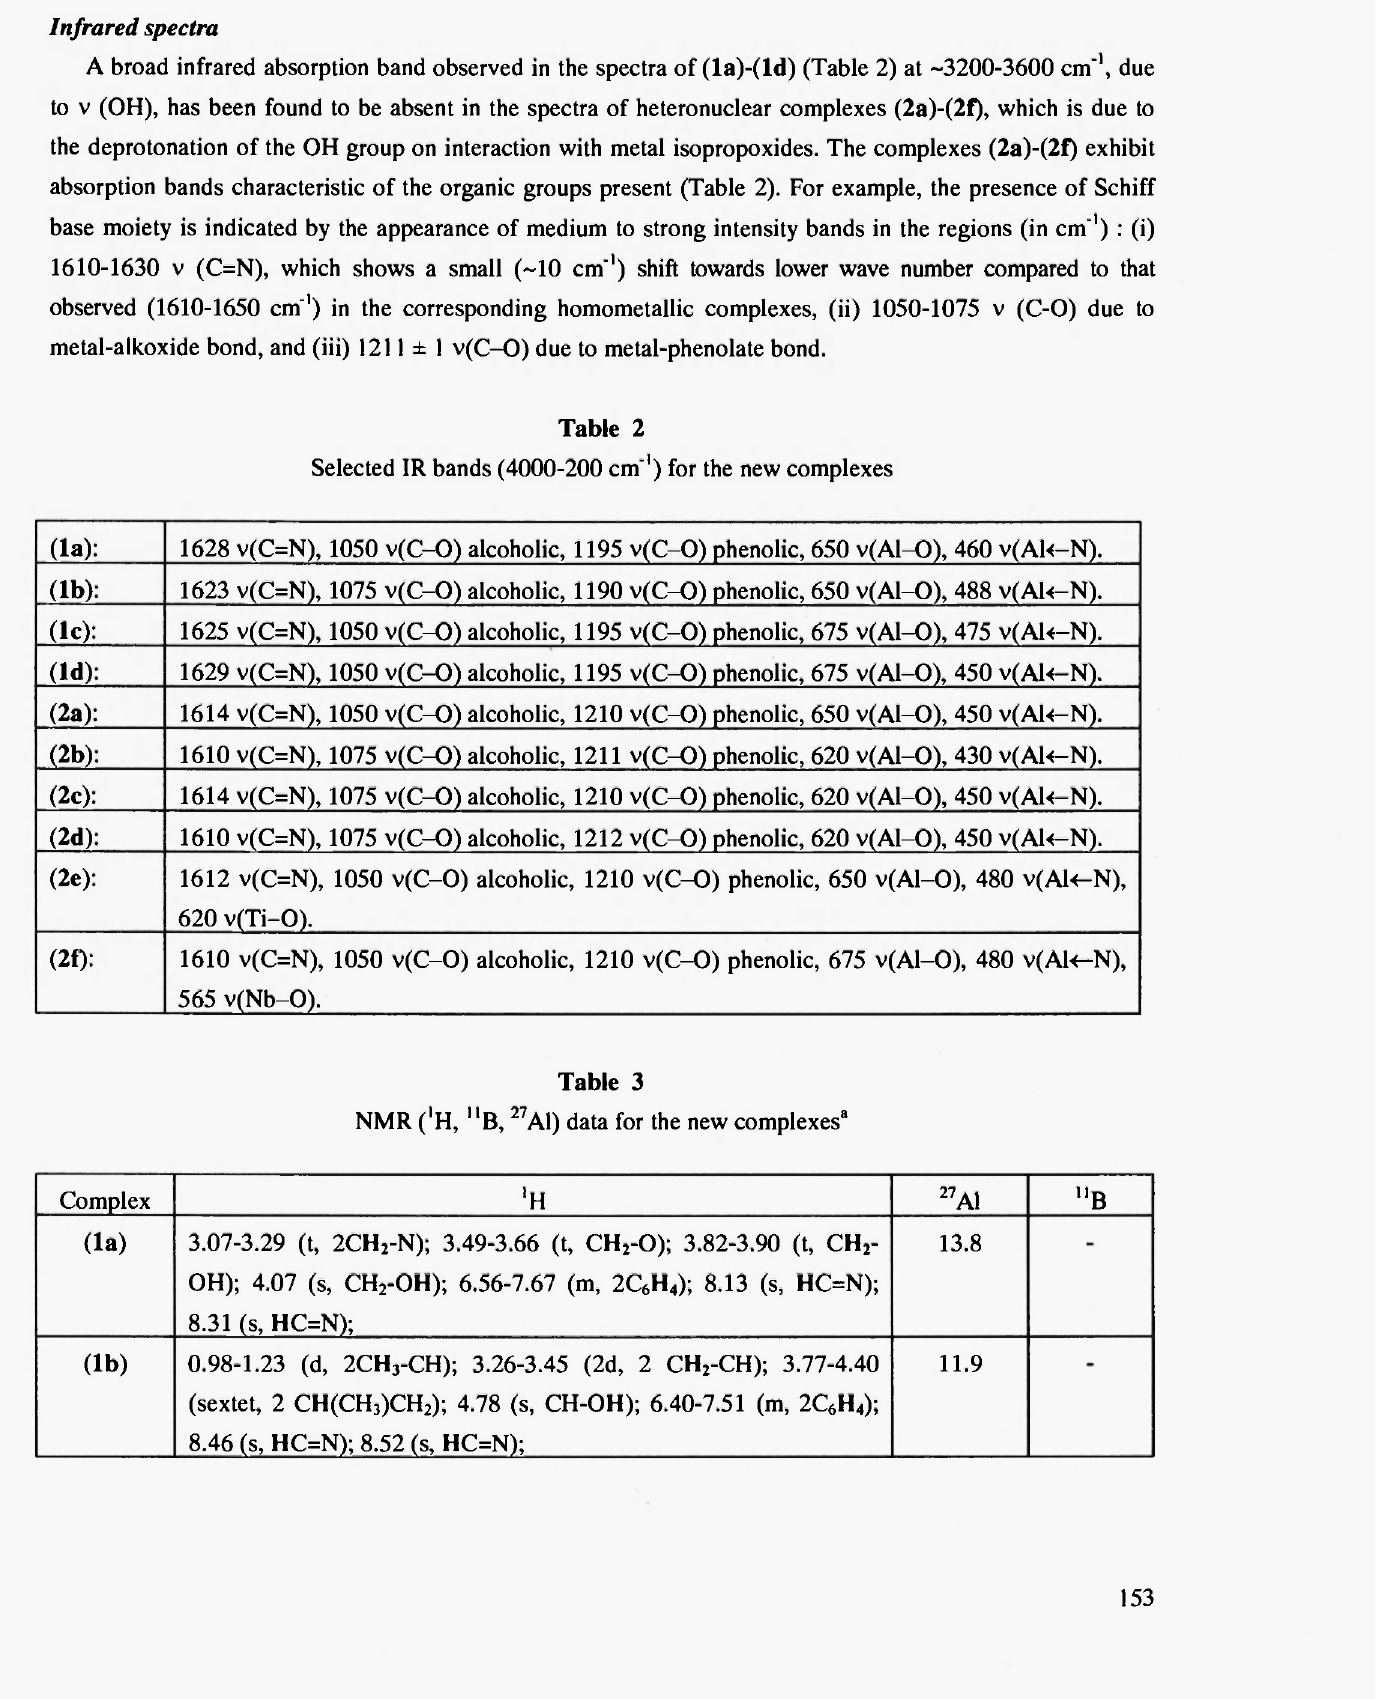
NMR ('Η, "B, 27 A1) data for the new complexes